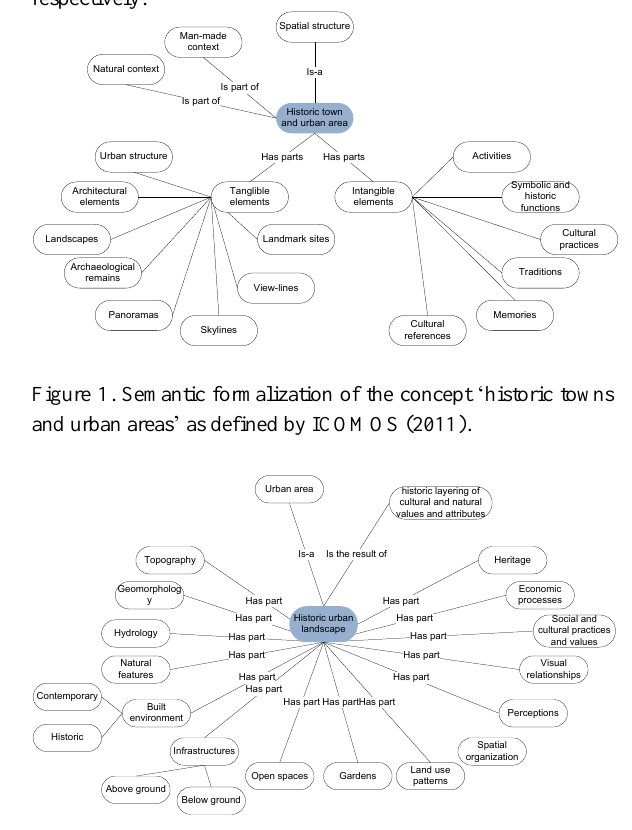
Figure 2. Semantic formalization of the concept ‘historic urban landscape’ as defined by ICOMOS (2011).